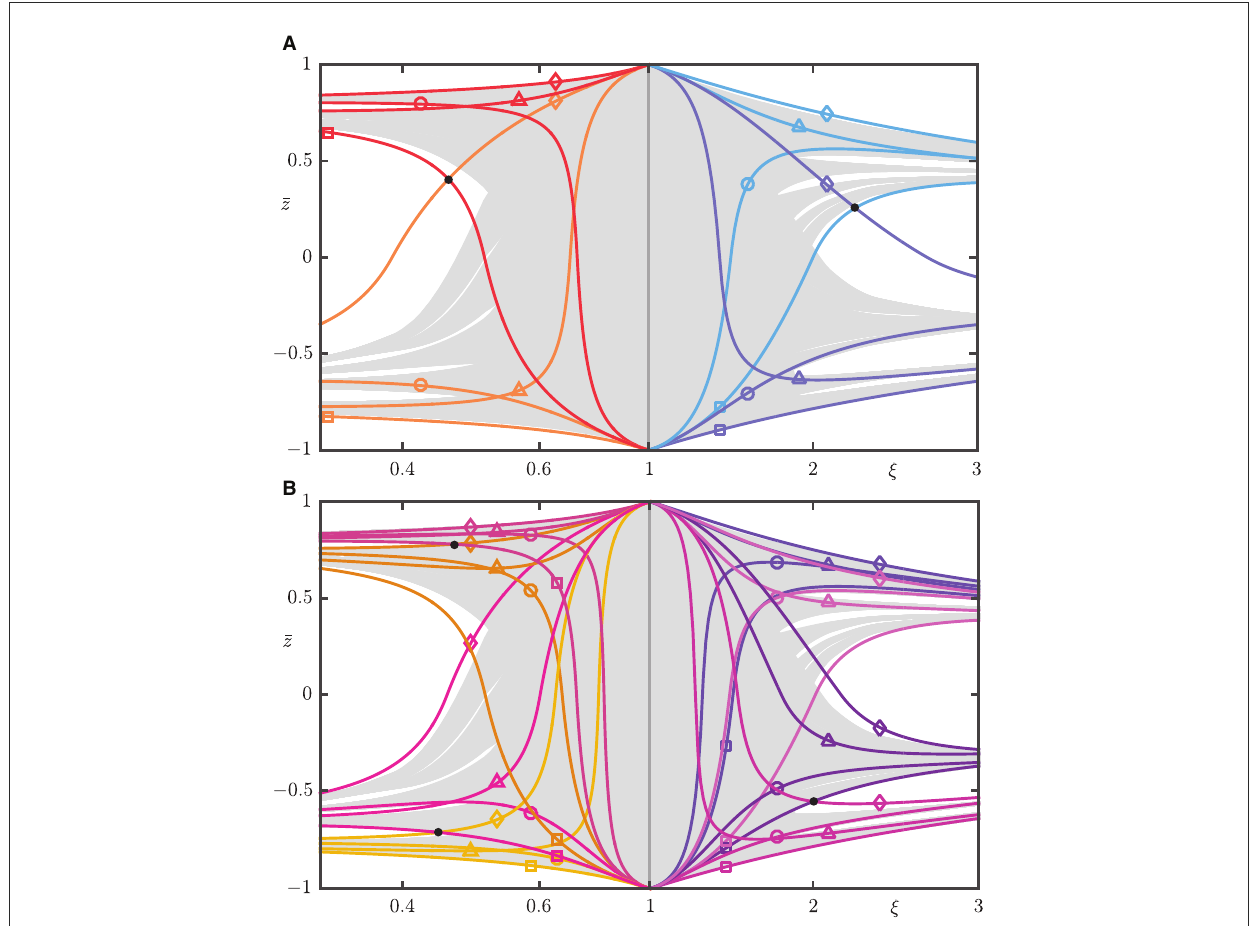
FIGURE12 Curves # ¯ z ( ξ ), 3 ¯ z ( ξ ), (cid:3) ¯ z ( ξ ), and △ ¯ z ( ξ ) for the sub-boxes B ± and D ± in (A) , and for the sub-boxes D ±∓ and B ±∓ in (B) , shown in the ( ξ , ¯ z )-plane with ,1] rescaled by Equation (16) to have width 2. Colors match those of the boxes in Figures 4, 6, 9, 11, and the gray background is formed by [ 1 3 ,1) and W s ( p ± ) ∩ 6 for ξ ∈ (1,3]. Black dots mark the intersection points of 3 ¯ z ( ξ ) and (cid:3) ¯ z ( ξ ) of opposing sub-boxes, which W u ( p ± ) ∩ 6 for ξ ∈ [ 1 3 indicate a gain/loss of overlap.